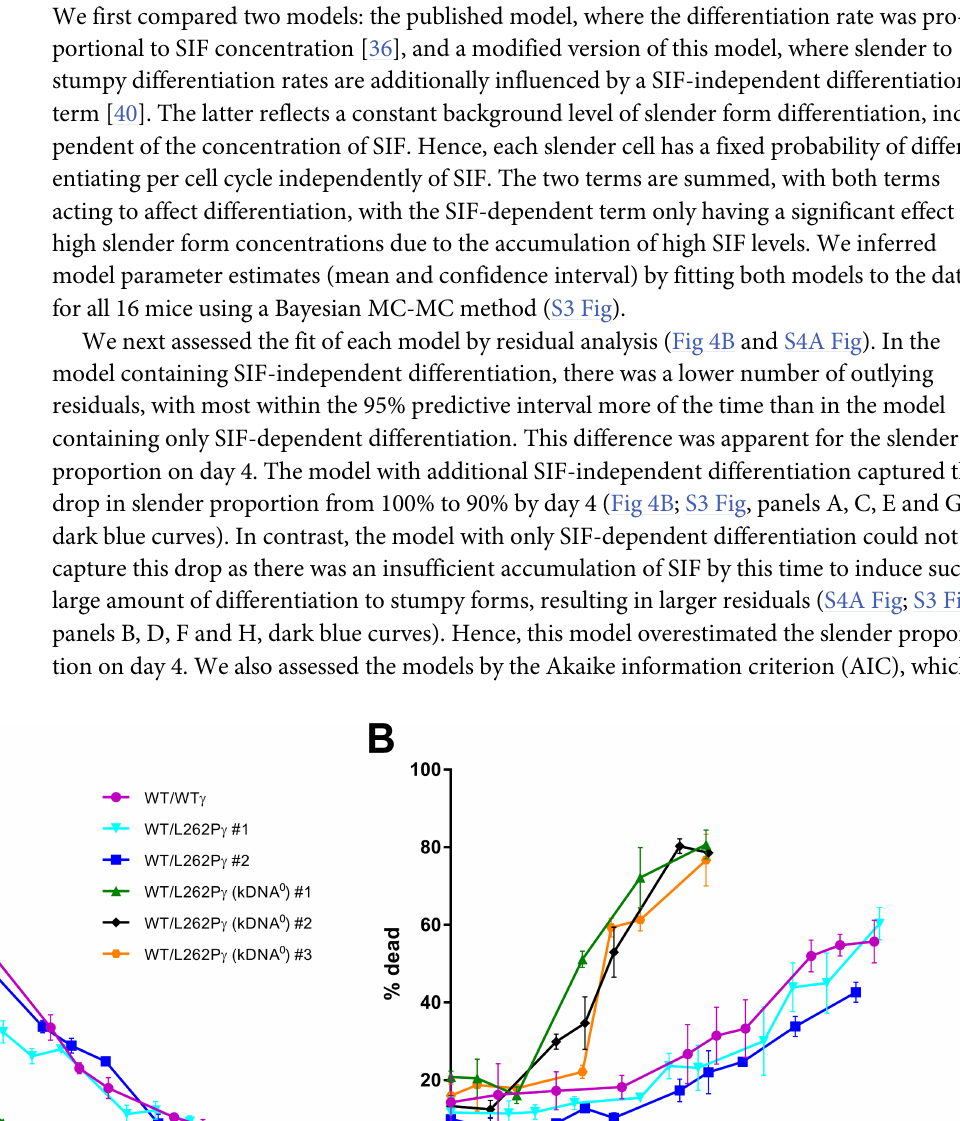
via the Rapid Matching method. (B) Data from panel A (up to day 6) plotted on a semi-log scale. (C) Fold-change in parasitaemia between time points (up to day 6). (D-H) The morphological changes occurring during these mouse infections, expressed as cell densities (D, slender forms; E, stumpy forms) or percentages (F, slender cells; G, intermediate cells; H, stumpy cells). Error bars are SEM. The population of cells were scored as having slender, intermediate or stumpy form morphology from DAPI-stained dry blood smears. (I) The levels of parasitaemia of stumpy forms per ml of blood, where t = 0 is the time point where the stumpy number was highest for each cell line. This time point was 6 days and 16 hours for cell lines WT/WT γ ,WT/L262P γ #2 and WT/ L262P γ (kDNA 0 ) #2, and 7 days and 12 hours for WT/L262P γ (kDNA 0 ) #1. Error bars are SEM.